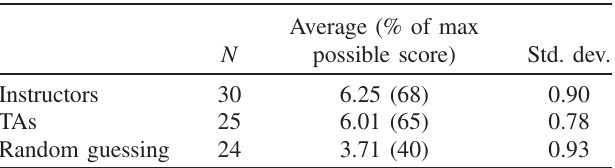
TABLE V. Numbers of instructors, TAs, and random guessers, averages (and percentage of maximum possible score), and standard deviations (Std. dev.) for the FCI-related PCK scores obtained (in determining introductory students ’ alternate con- ceptions on the FCI) out of a maximum score of 9.21. FIG. 4. Diagram for question 19.